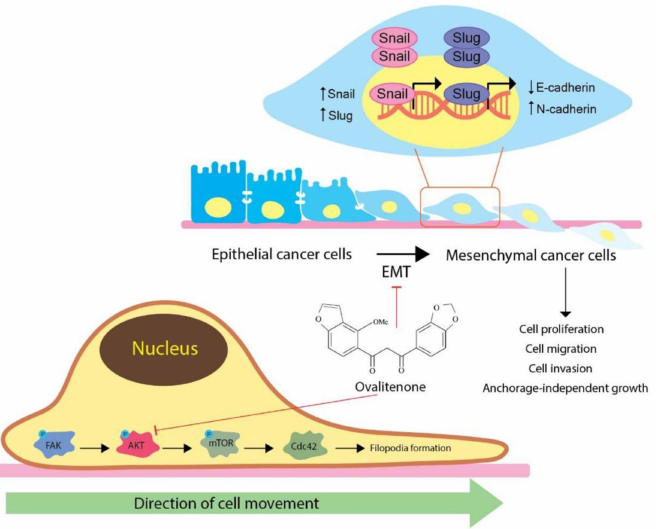
Figure 7. The schematic diagram summarizes the underlying mechanism of ovalitenone-attenuating EMT in lung